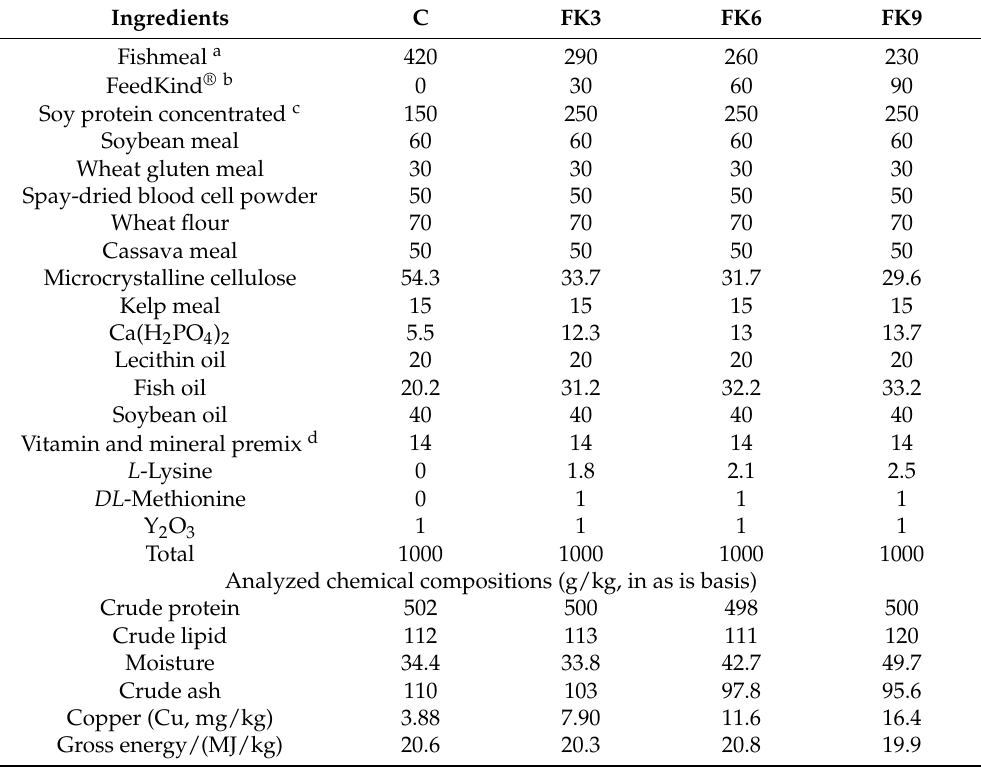
Table 1. Formulation and composition of experimental diets (g/kg).